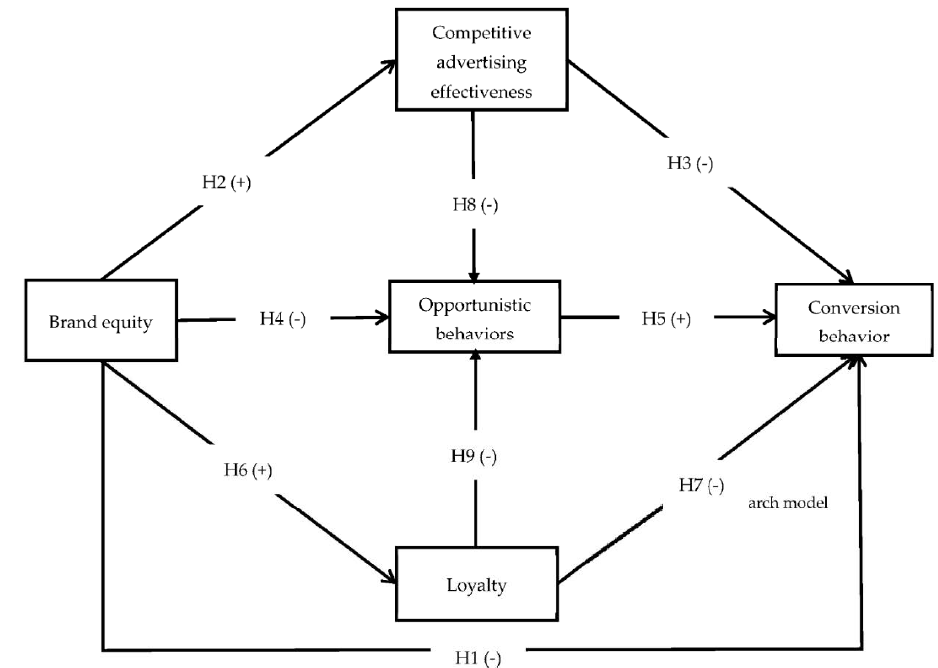
Figure 1. Research model.